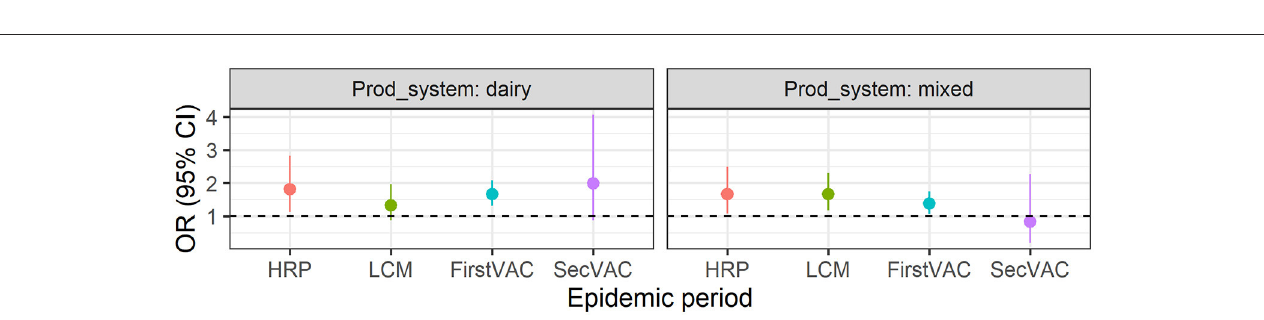
FIGURE6 Odds ratio (OR) of production system being “beef” the reference, after controlling for all variables included in the model for each epidemic period. HRP, the high-risk period; LCM, local control measures period; FirstVAC and SecVAC are the first (dose).